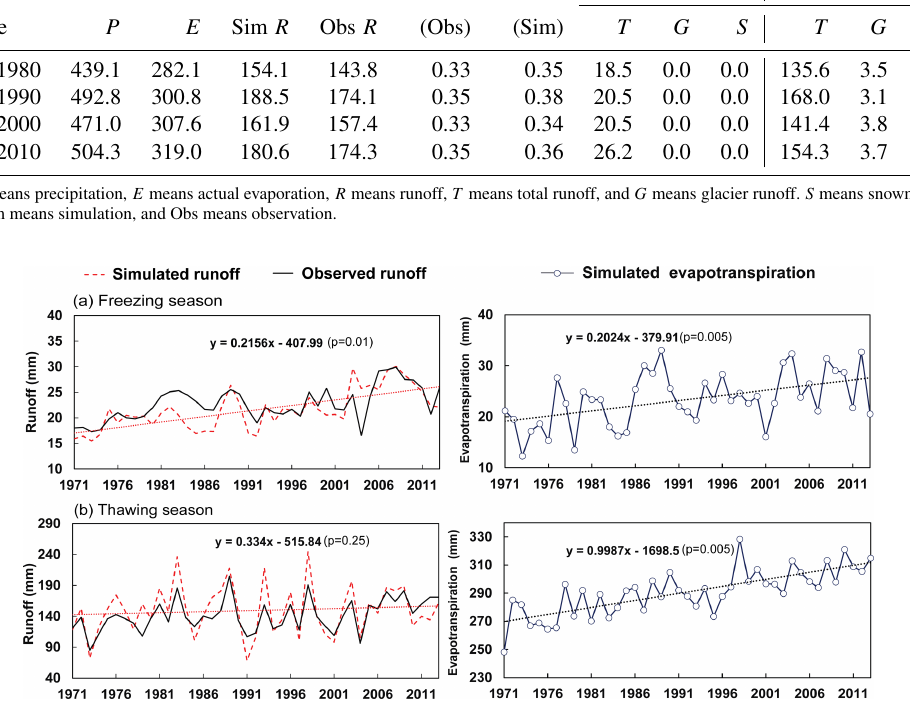
Figure 11. Runoff and simulated evapotranspiration in (a) the freezing season and (b) the thawing season for the period of 1971 to 2013. Trend lines are for simulated data and regression results are shown. The upper two panels represent the freezing season and the lower two panels represent the thawing